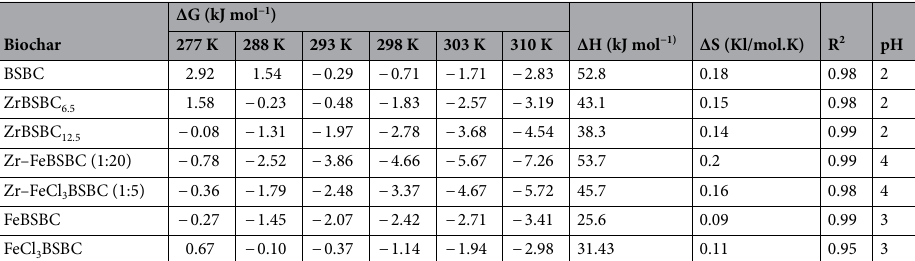
Table 3. Thermodynamic parameters for the sorption of Sb(V) on